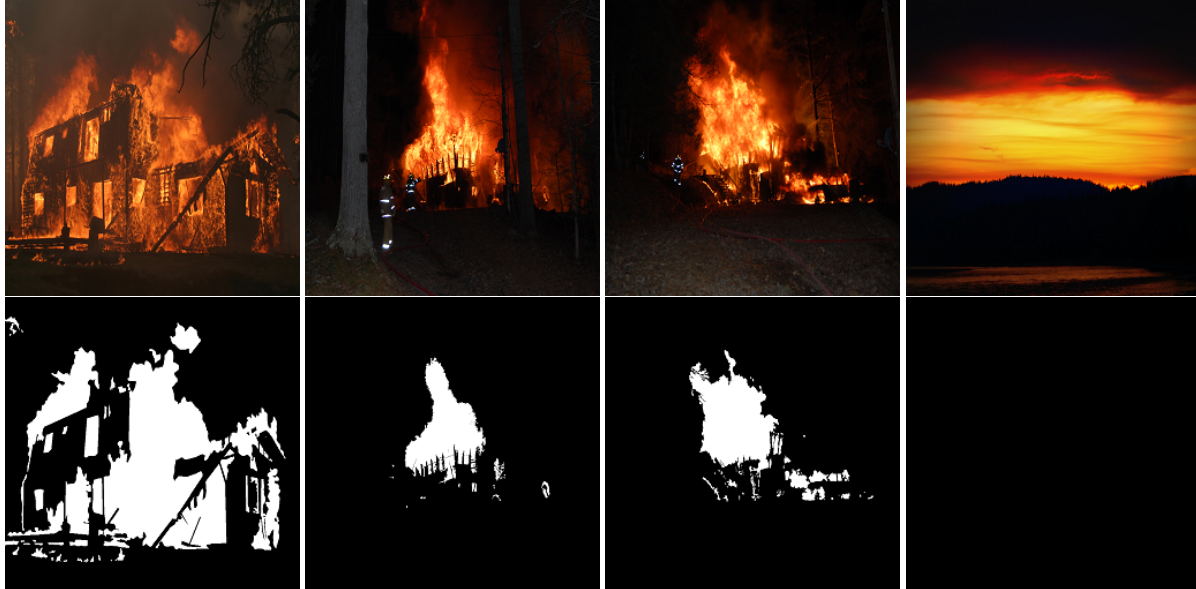
Figure 4. Examples from the BowFire dataset. ( Top ): Fire images; ( Bottom ): non-fire images.